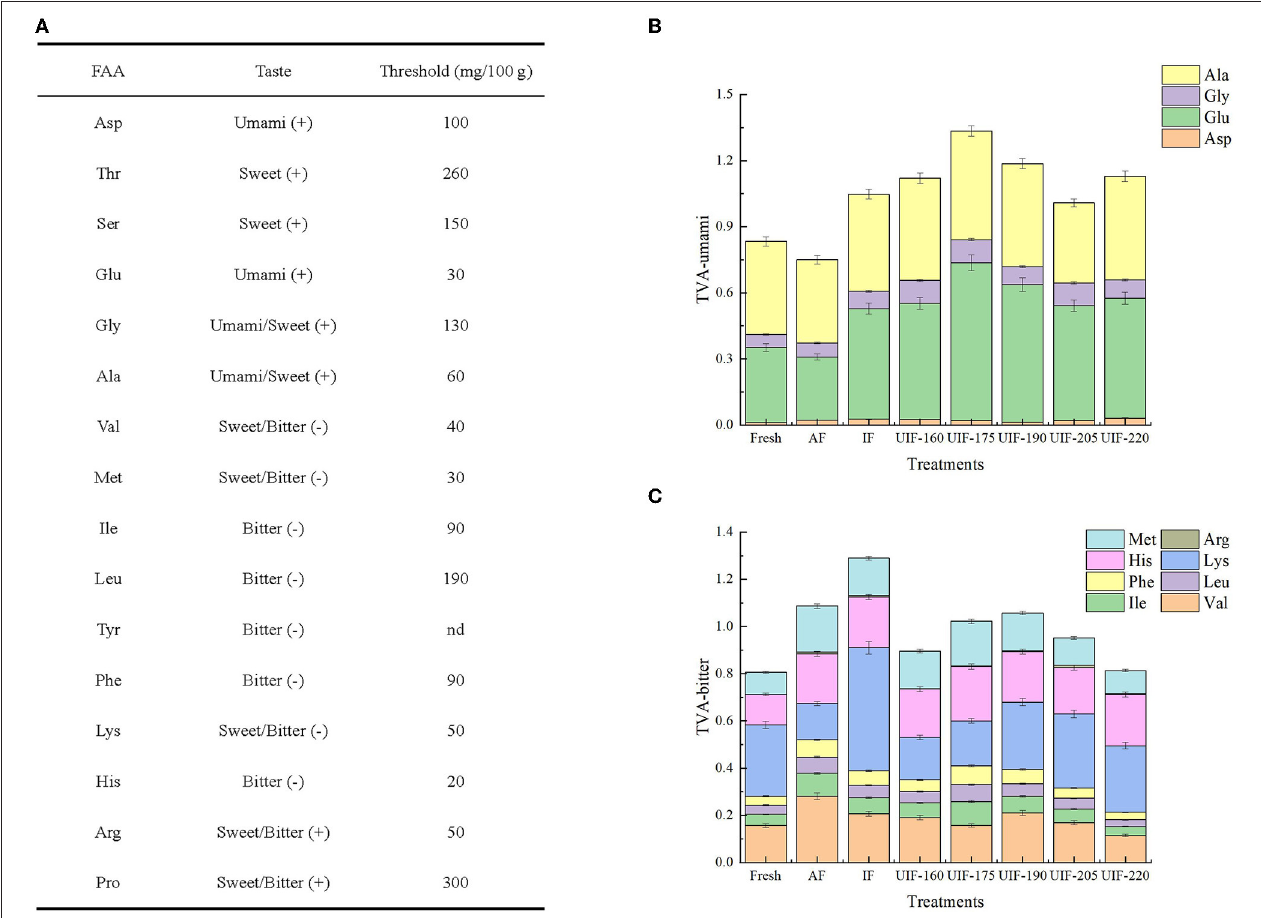
FIGURE 10 | The thresholds of different amino acids taste (A) , changes in umami-TVA (B) , and bitterness-TVA (C) of fresh and frozen large yellow croaker under different freezing treatments.